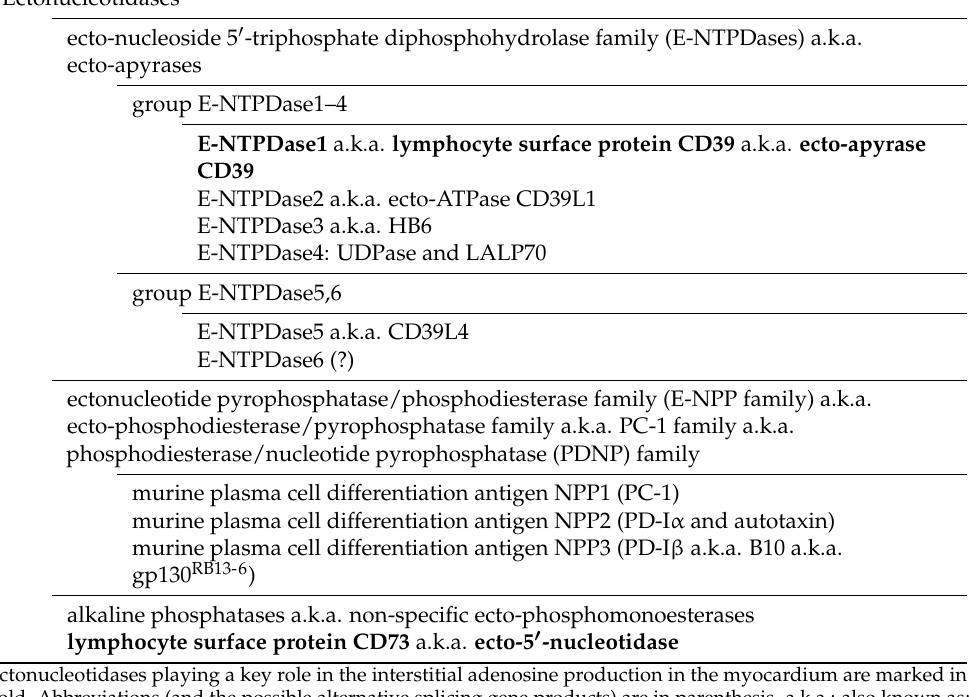
Table 1. Ectonucleotidases, enzymes participating in the extracellular adenosine formation [29].